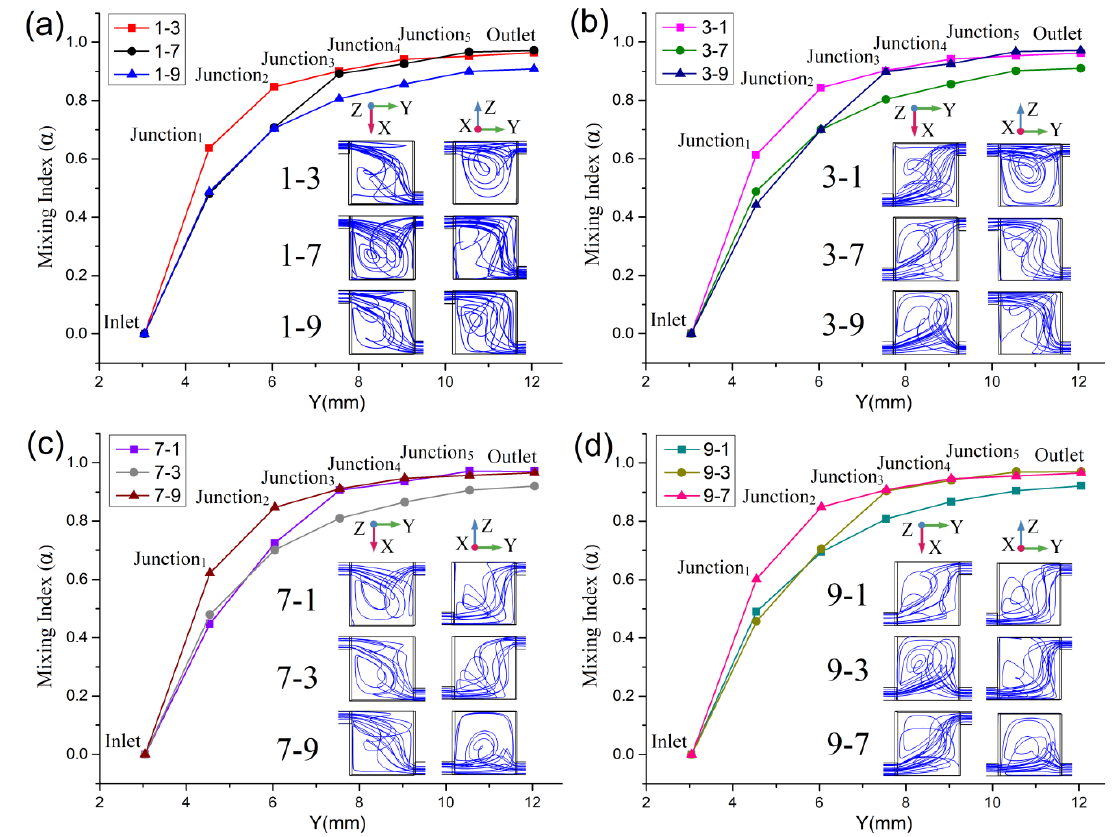
Figure 7. The mixing indexes of repetitive structure micromixers with inconsistent junction location combinations: ( a ) combination of Location 1 and other locations; ( b ) combination of Location 3 and other locations; ( c ) combination of Location 7 and other locations; ( d ) combination of Location 9 and other